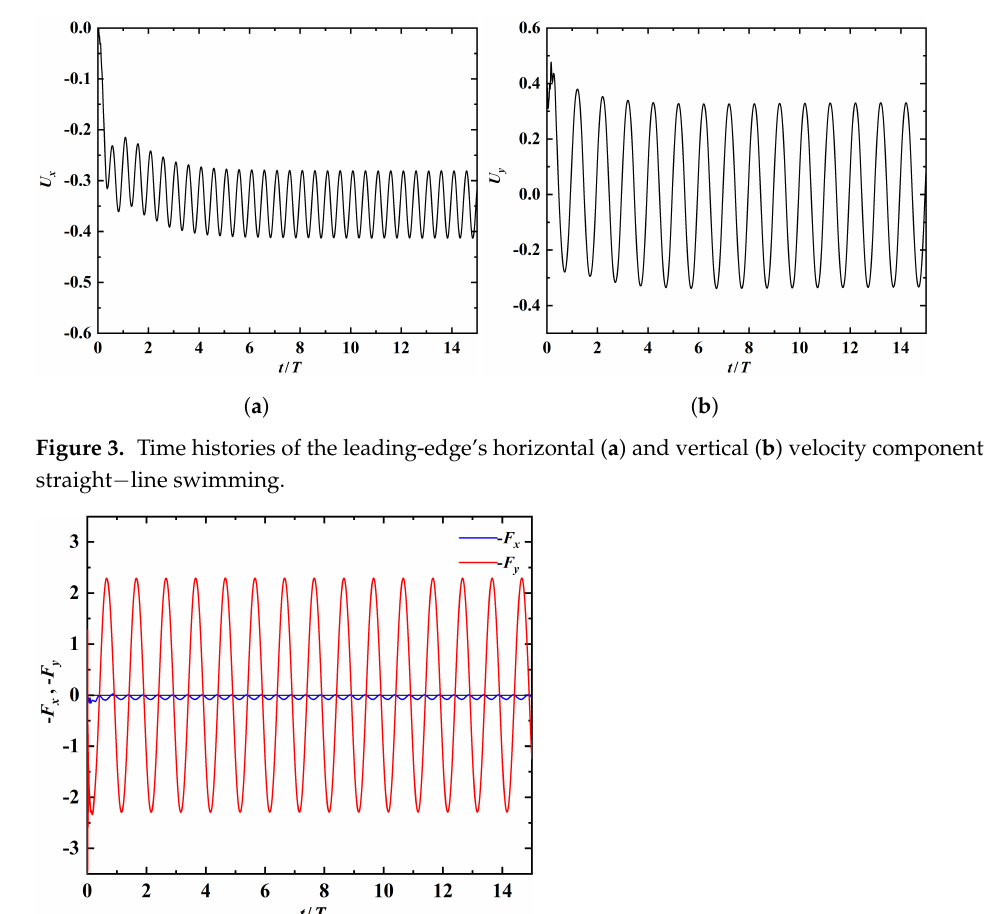
Figure 4. Time histories of the horizontal and vertical components of fluid force on the propulsor in straight-line swimming.